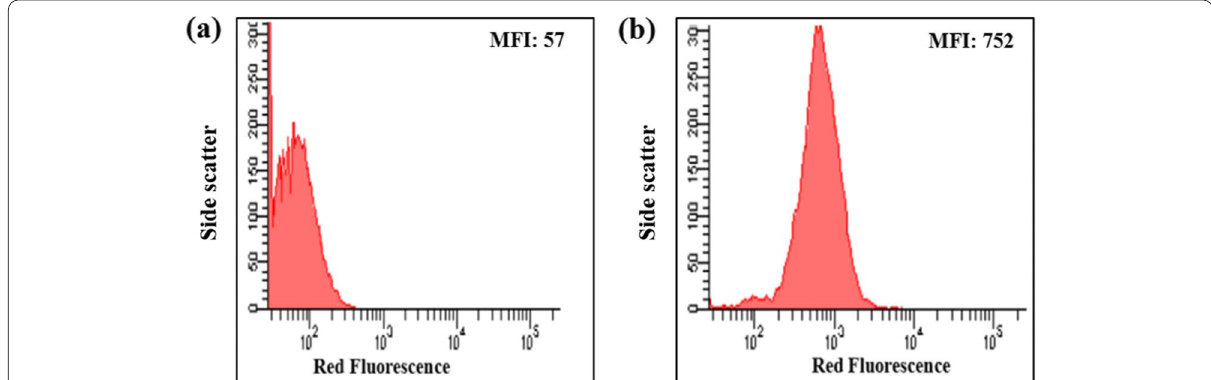
Fig. 2 Histogram plots showing binding of NBA to Bacillus sp. LPPI-18 obtained from Loktak Lake sediment. a Unstained culture of Bacillus sp. LPPI-18 with 57 MFI and b stained culture of Bacillus sp. LPPI-18 with 752 MFI in the presence of NBA at final concentration of 0.5 μg/l